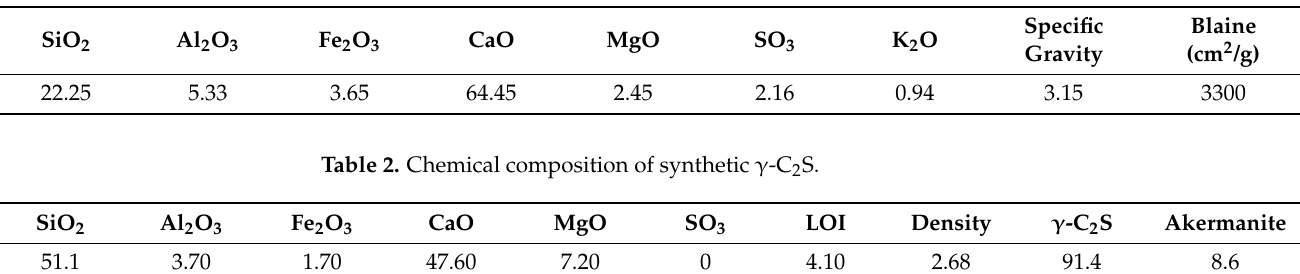
Table 1. Chemical composition of the OPC used.